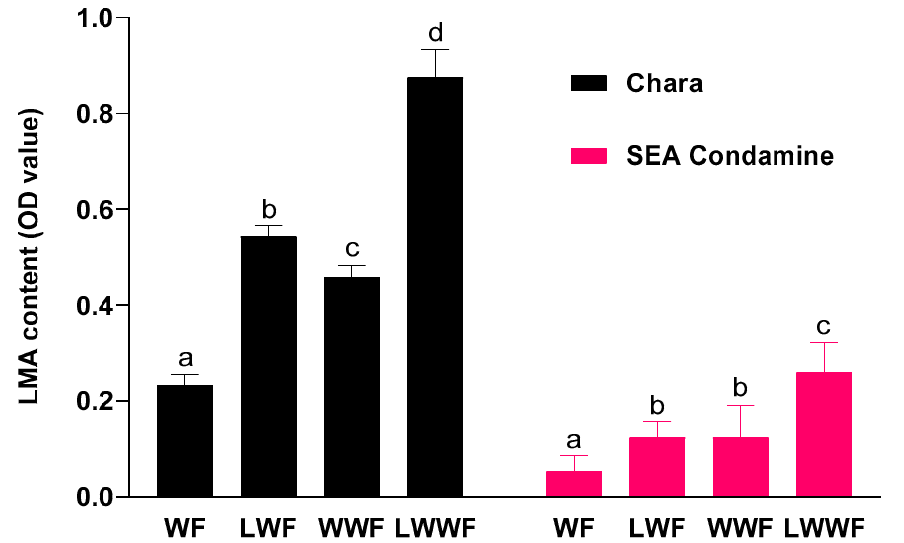
Figure 1. LMA content in white and whole-wheat flour milled from wheat grown under different condition during late post-anthesis stage. (WF) control white flour; (LWF) LMA-affected white flour; (WWF) control whole-wheat flour; (LWWF) LMA-affected whole-wheat flour. Respective cultivars marked by different letters indicate significant differences ( p ≤ 0.05).